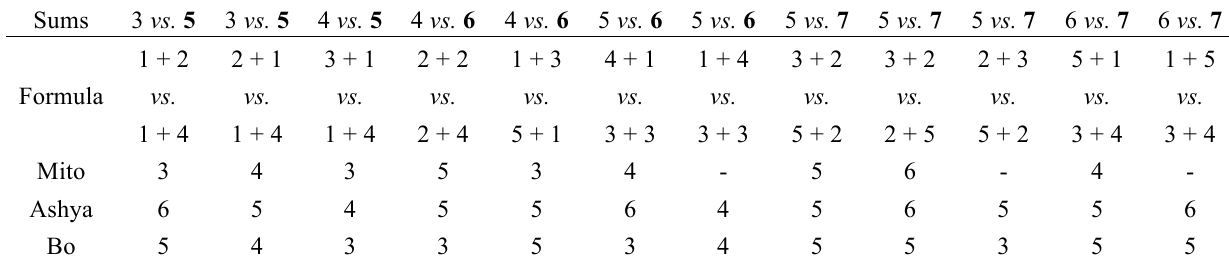
Table 1. The presented summation comparisons and number of correct trials (out of six trials per